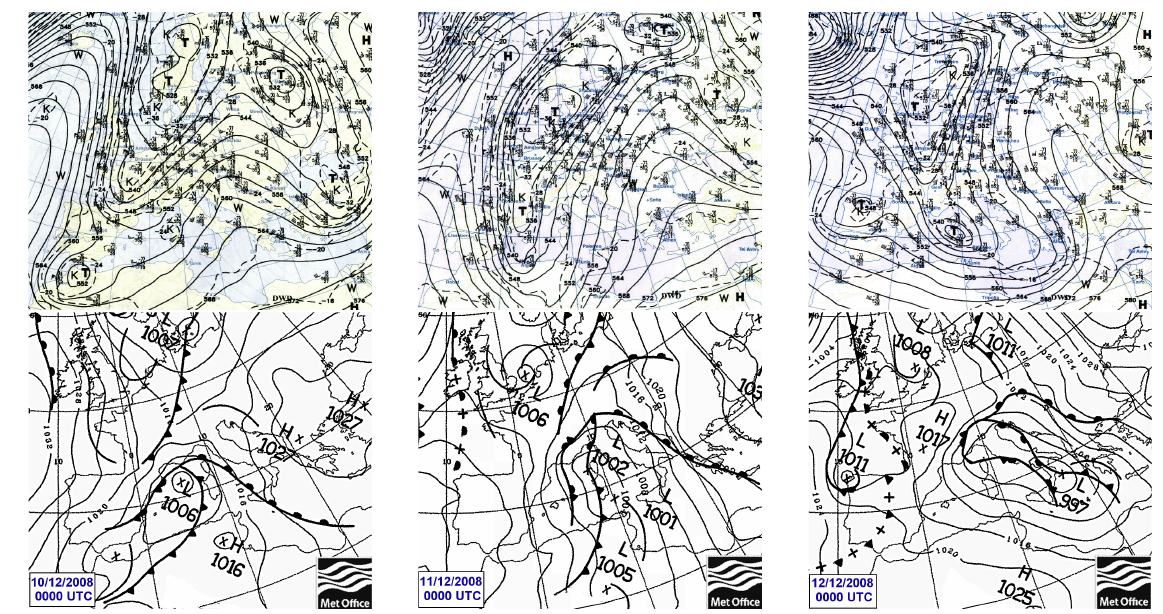
Fig. 1. 500-hPa (top row, courtesy of Berliner Wetterkarte) and surface (bottom row, courtesy of UK MetOffice) weather charts at 00:00UTC for 10 December 2008 (left), 11 December 2008 (middle), and 12 December 2008 (right).